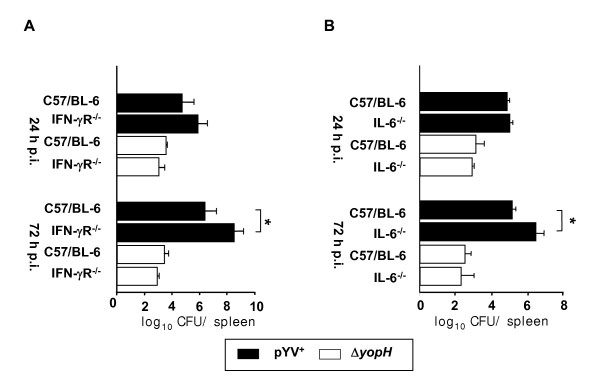
IFN-γR and IL-6 are not necessarily required for the control of Ye ΔyopH infection. IFN-γR-/- (A) or IL-6-/- (B) mice as well as C57BL/6 mice were infected intravenously with 5 × 104 pYV+ (black bars) or 5 × 104 ΔyopH (white bars). The bacterial number was assessed in spleens 24 and 72 hours after infection. Values represent the average log10 CFU per spleen with the standard errors of the means indicated by error bars (5–10 mice per group). Asterisks indicate significant differences (p < 0.05, Wilcoxon Rank test) between the compared groups. Two further independent experiments showed comparable results.